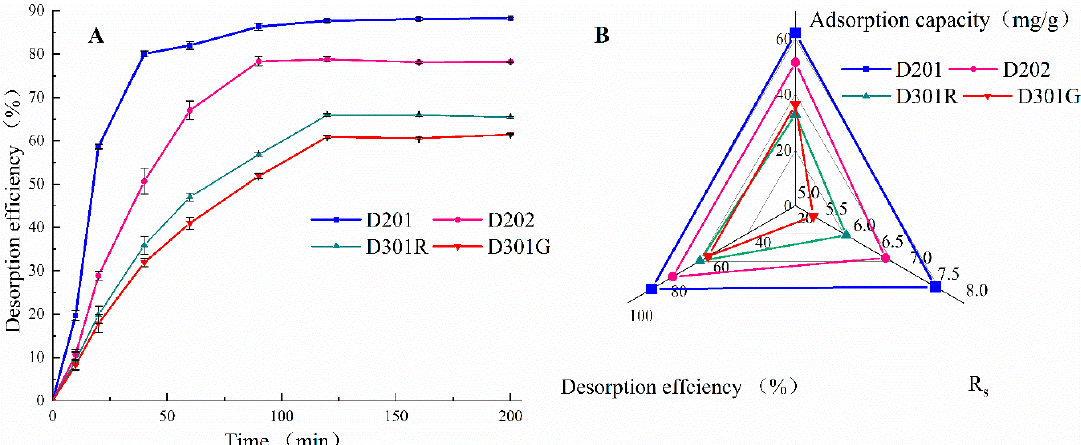
Figure 3. ( A ) The desorption efficiency and ( B ) overall performance of different resins (D201, D202, D301R, and D301G) in the simulated fermentation broth. The results present with averages and standard deviations of three parallel experiments. The indicators of the resin performance in ( B ) comprise of adsorption capacity, desorption efficiency, and selectivity (Rs).